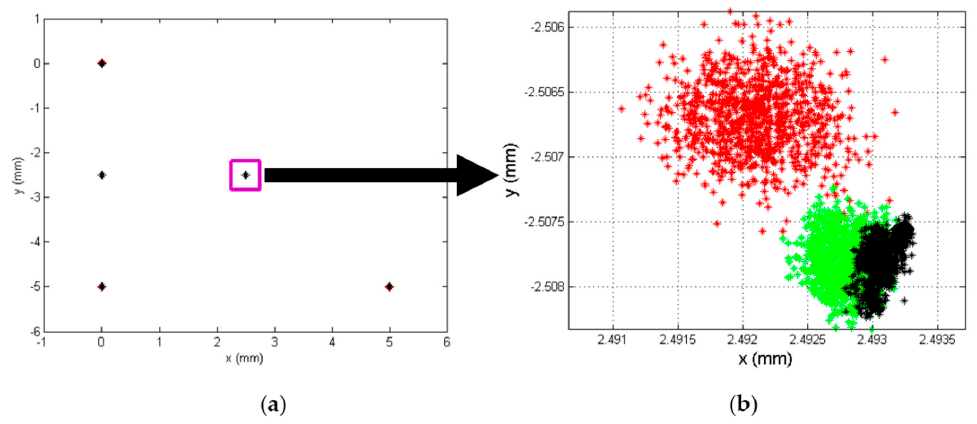
Figure 25. ( a ) Error due to noise for a SNR at 40 dB (red), 50 dB (green) and 60 dB (black).; ( b ) Enlarged of the (2.5, − 2.5) point. Table 3. Comparison between simulated and measured errors.